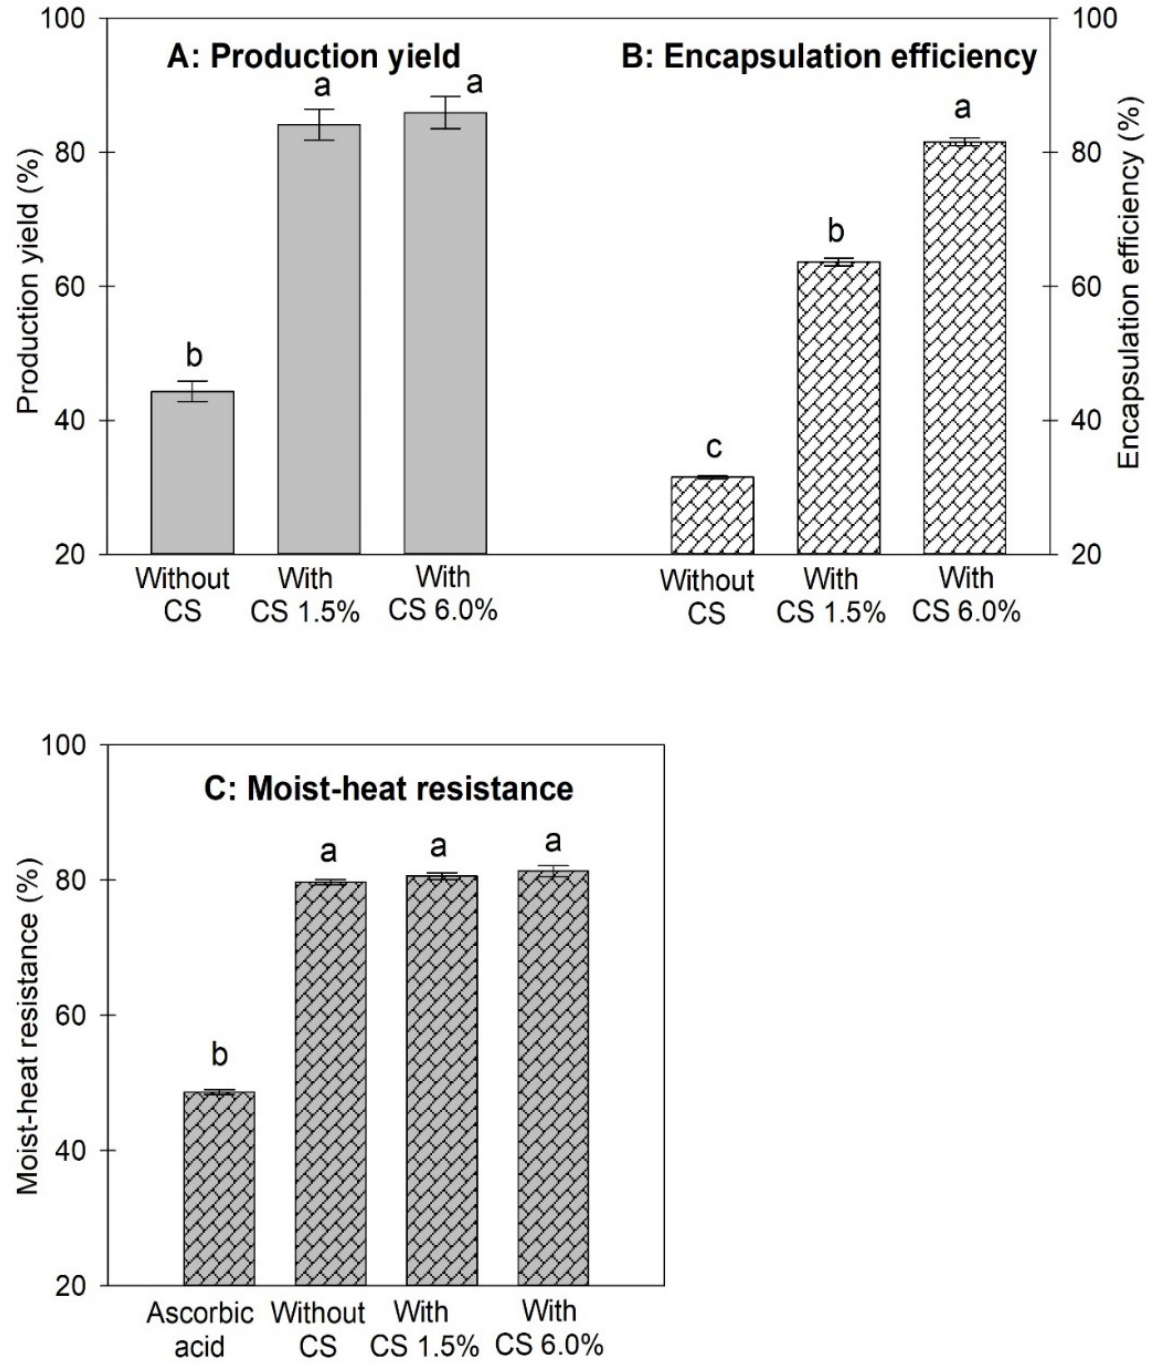
Figure 2. ( A ) Production yield of microcapsules E1A1 produced without or with using CS as a coencapsulation material at a blending ratio of 1.5 or 6% of EY. ( B ) Encapsulation efficiency of microcapsules E1A1 produced without/with using CS as a coencapsulation material at a blending ratio of 1.5 or 6% of EY. ( C ) Moist heat resistance of unencapsulated AA and microencapsulated AA E1A1 produced without or with using CS at a mass ratio of 1.5 or 6% of EY. The different superscripts in each figure indicate significant differences of the values ( p <